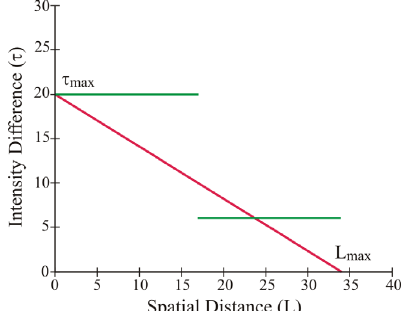
Figure 4. Expansion of the cross-based support region S( p ) dri- ven by the skeleton of each pixel. The skeleton pixels for V( p ) and H( p ) sets are calculated only once per pixel. When pixel q belongs to V( p ), the corresponding horizontal arm H( q ) is add- ed to S( p ). S( p ) consists of the union of H( q ) for all pixels q which participate in V( p ). [After Zhang et al., 2009.]